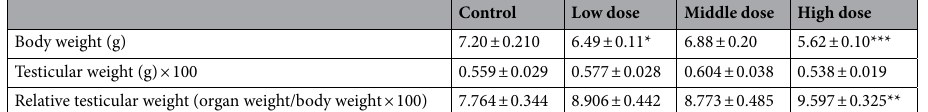
Table 1. Body and testicular weights of CORT-administered mice on PND 10. Values are expressed as the mean ± S.E.M. of 12 samples per group. *p < 0.05, **p < 0.01, and ***p < 0.001. CORT